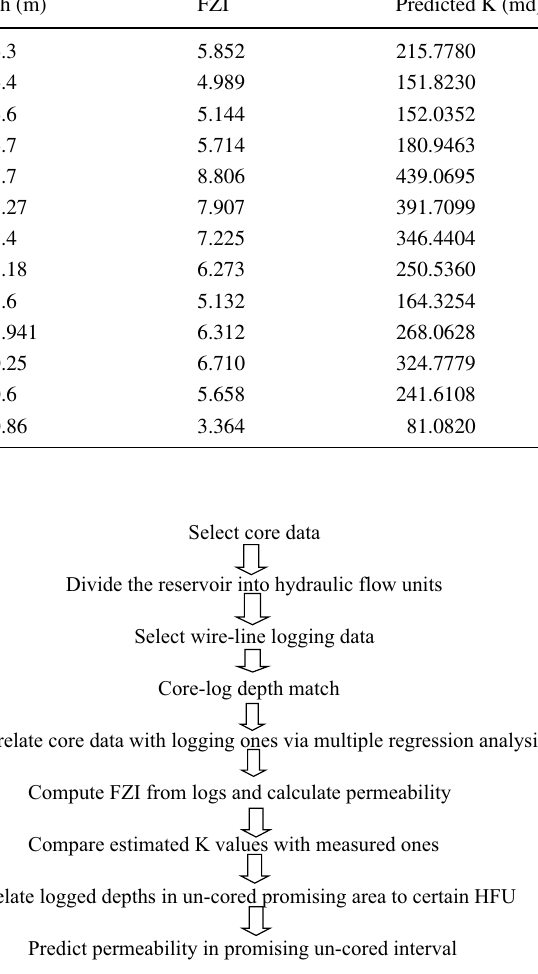
Table 2 FZI and predicted permeability values at promising area at JG-12 Depth (m) FZI Predicted K